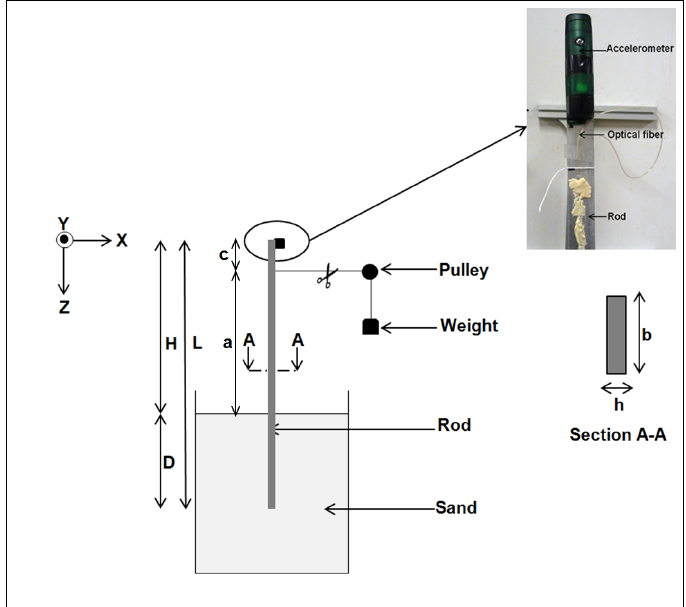
Figure 1. Experimental setup of the static and dynamic tests and close up look to fiber optic installation. L is the length of the beam, with D the embedded length and H the exposed length. a is the exccentricity of the load to the soil level. The scissors show where the thread has been cut to apply the lateral